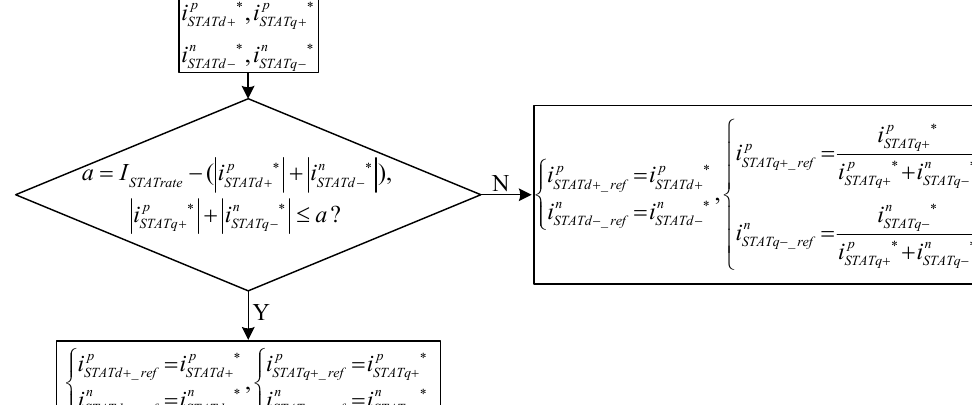
Figure 8. Calculation algorithm for the STATCOM current